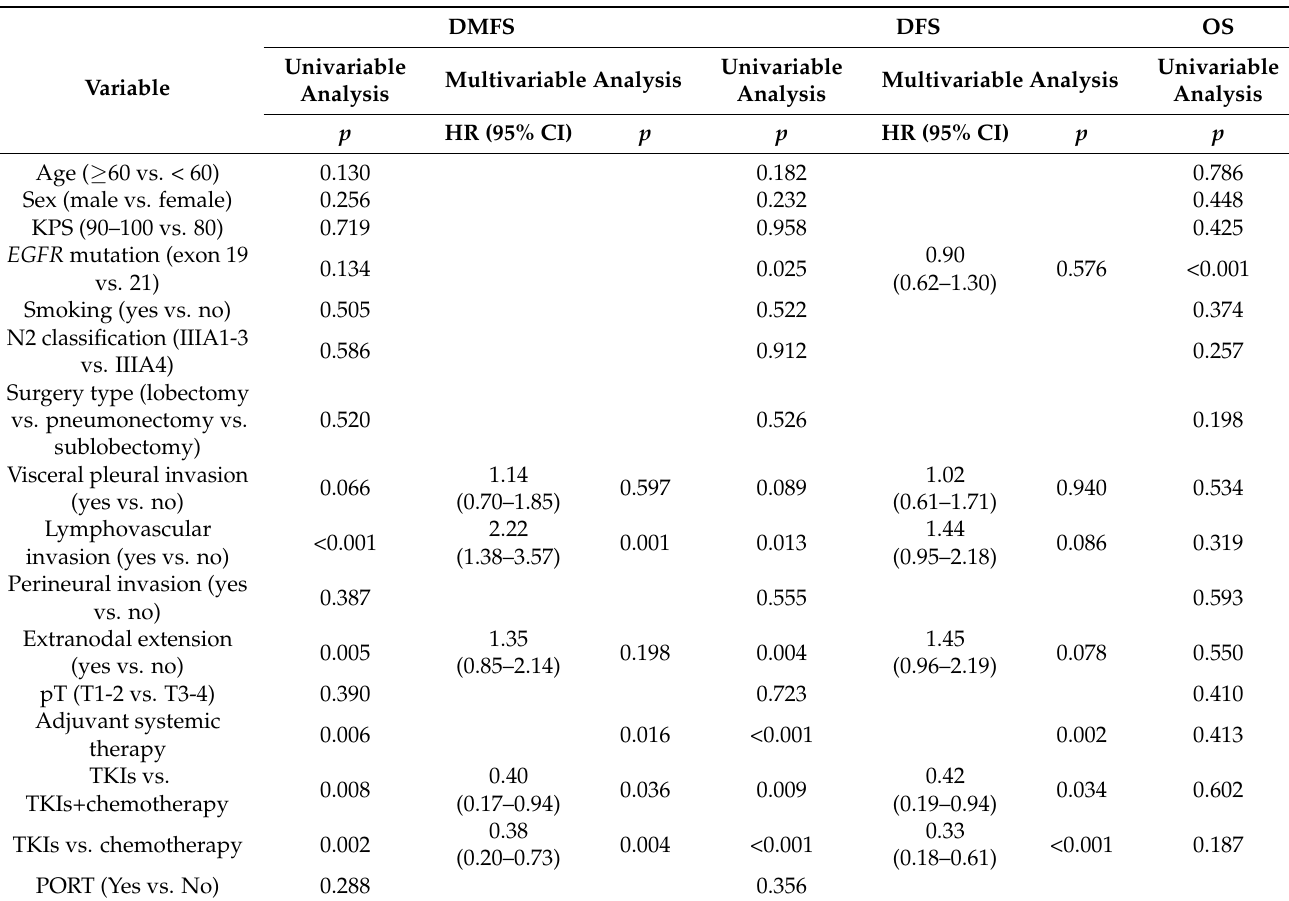
Table 3. Univariable and multivariable analyses of prognostic factors on